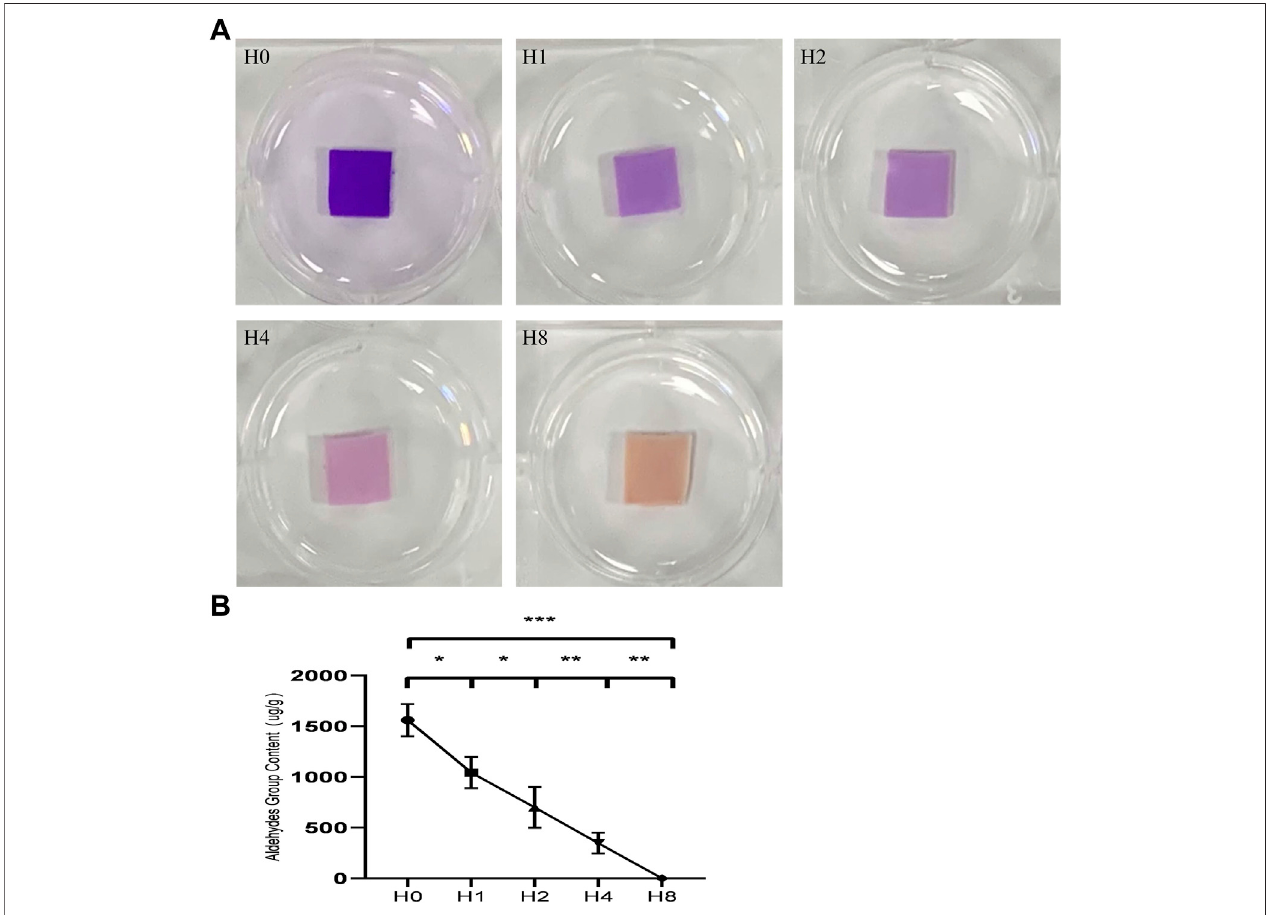
FIGURE 2 | Qualitative and quantitative detection of aldehyde groups: (A) : results of different treatments of BPs stained with Schiff reagent, The color intensity is positively correlated with the content of aldehyde groups after the color reaction, The conditions of each group are as follows: H0:GLUT treated group; H1: GLUT+1 mmol/LGSHtreatedgroup;H2:GLUT+2 mmol/LGSHtreatedgroup;H4:GLUT+4 mmol/LGSHtreatedgroup;H8:GLUT+8 mmol/LGSHtreatedgroup; (B) is thequalitativecontentofaldehydegroupsfromdifferentBPgroupsrespectively( n =4; p p < 0.05; pp p < 0.01; ppp p < 0.001;nsrepresentsnosigni fi cantdifference).